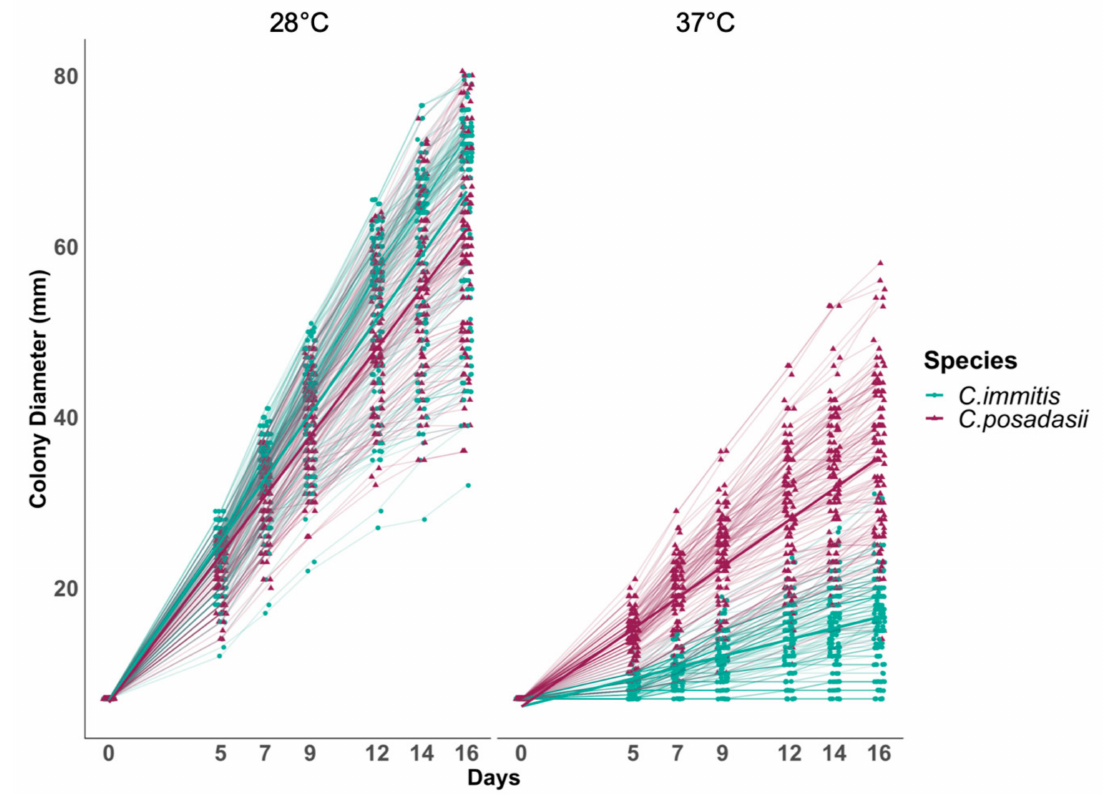
Figure 2. Radial growth rate of 85 isolates of Coccidioides demonstrates species-specific response to temperature. Each line represents the mean diameter ( y -axis) for each isolate in triplicate (46 C. immitis and 39 C. posadasii ) at a given time point ( x -axis). Dark lines represent mean growth rate of each species. Radial growth was measured at day 5, 7, 9, 12, 14 and 16. There is a significant di ff erence in growth rate (slope) in response to higher temperature between species of Coccidioides . The radial growth rate of C. immitis is decreased at a higher temperature 37 ◦ C (slope37 = 0.64 mm / day; 95% C.I. 0.51–0.78) compared to C. posadasii (slope37 = 1.82 mm / day; 95% C.I. 1.49–2.16). Both species appear to tolerate 28 ◦ C and grow at a similar rate ( C. immitis slope28 = 3.73 mm / day; 95% C.I. 3.53–3.92, C. posadasii , slope28 = 3.47 mm / day; 95% C.I.